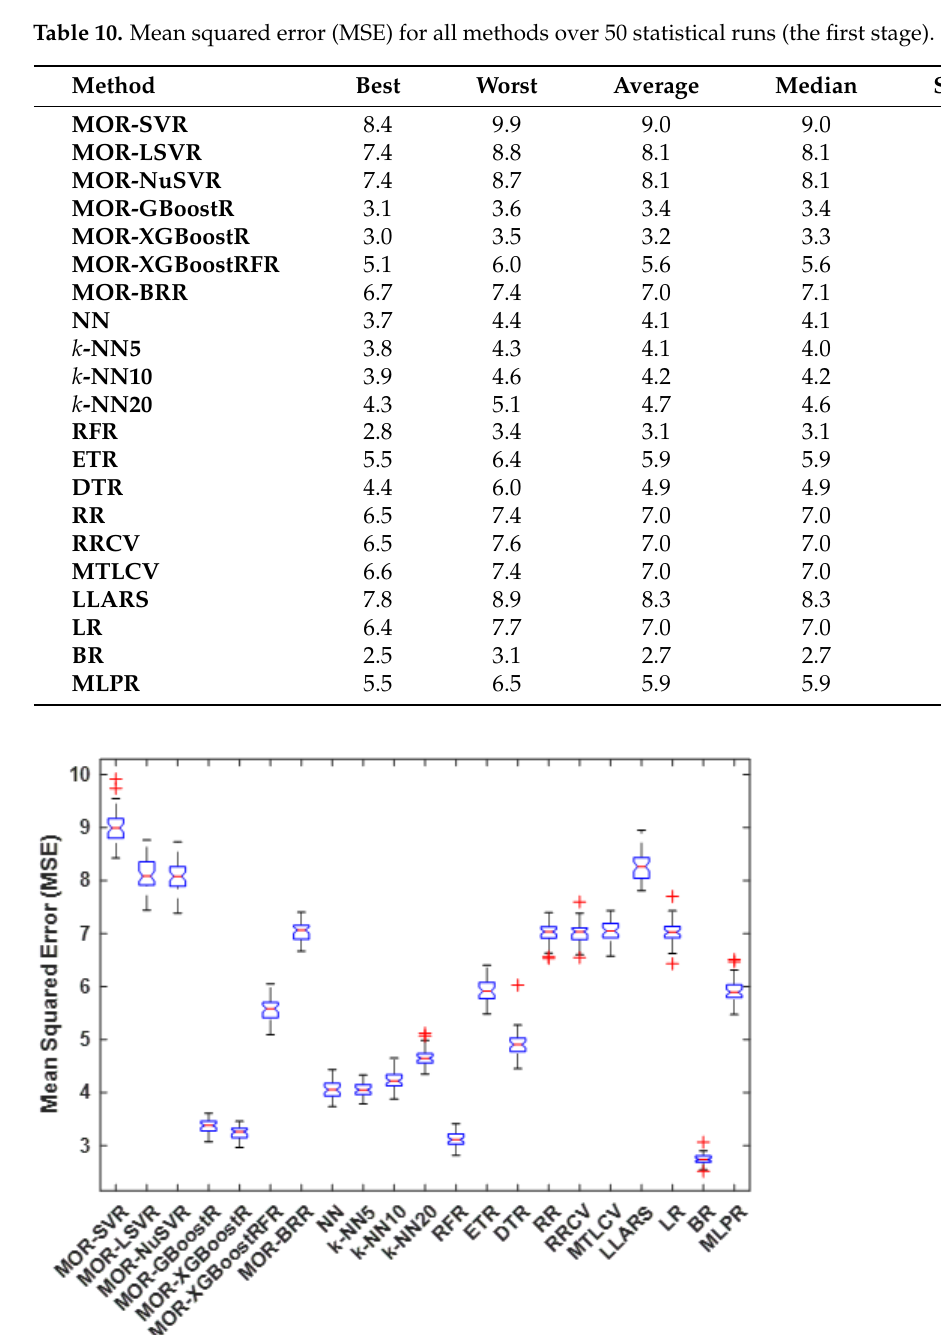
Figure 9. Box plots of MSE (over 50 statistical runs) for all methods for the first